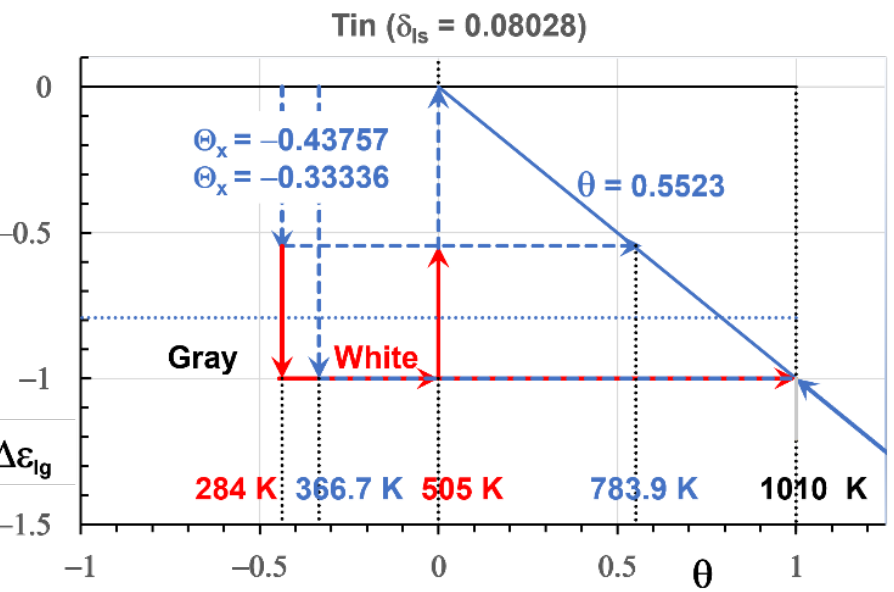
Figure 3. Tin glassy phase fraction f = ∆ ε expected after undercooling and reheating. T x = 284 K ( θ x = − 0.43757), leading to a Liquid-liquid transition at T n+ = T g = 783.9 K after reheating. ( ∆ ε = 0.5523) corresponding to the enthalpy coefficient of the gray phase. The crystallized fraction (1 − ∆ ε ) of the white phase is (0.4477). The glassy phase with T g = 2 T m = 1010 K and ∆ ε = 1 is nucleated at T x = 366.7 K ( θ x = − 0.33336) and heated without crystallization at T m .